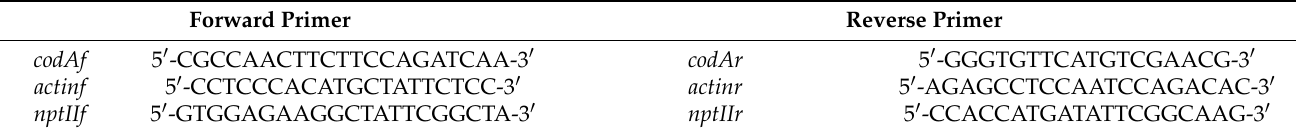
Table 1. List of primers used for the confirmation of the transgene presence in putative transformants. Forward